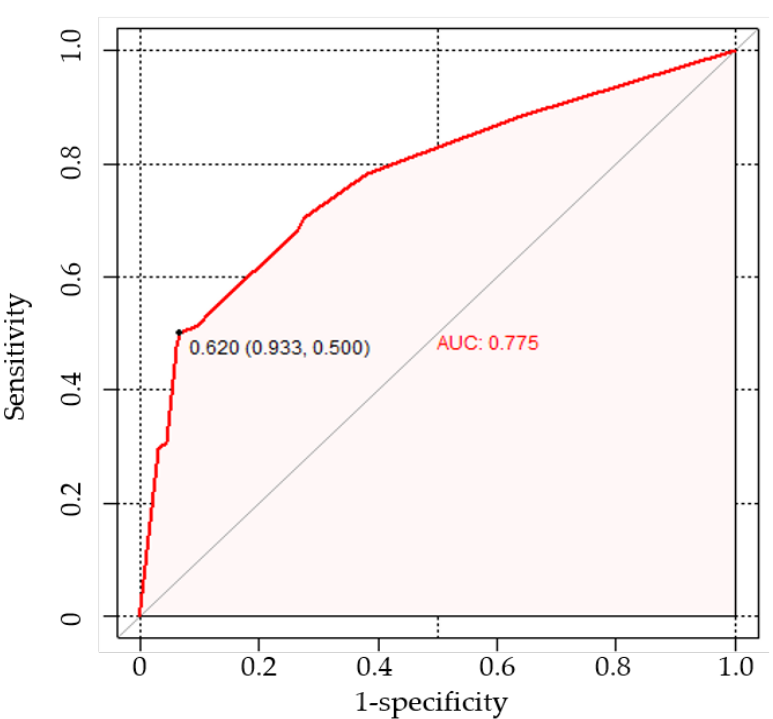
Figure 3. Receiver operating characteristic curve of the nomogram indicating an area under the curve of 0.775 (95% confidence interval, 0.713–0.829) in predicting LNM in patients with epithelial ovarian cancer. Abbreviations: LNM, lymph node metastasis.